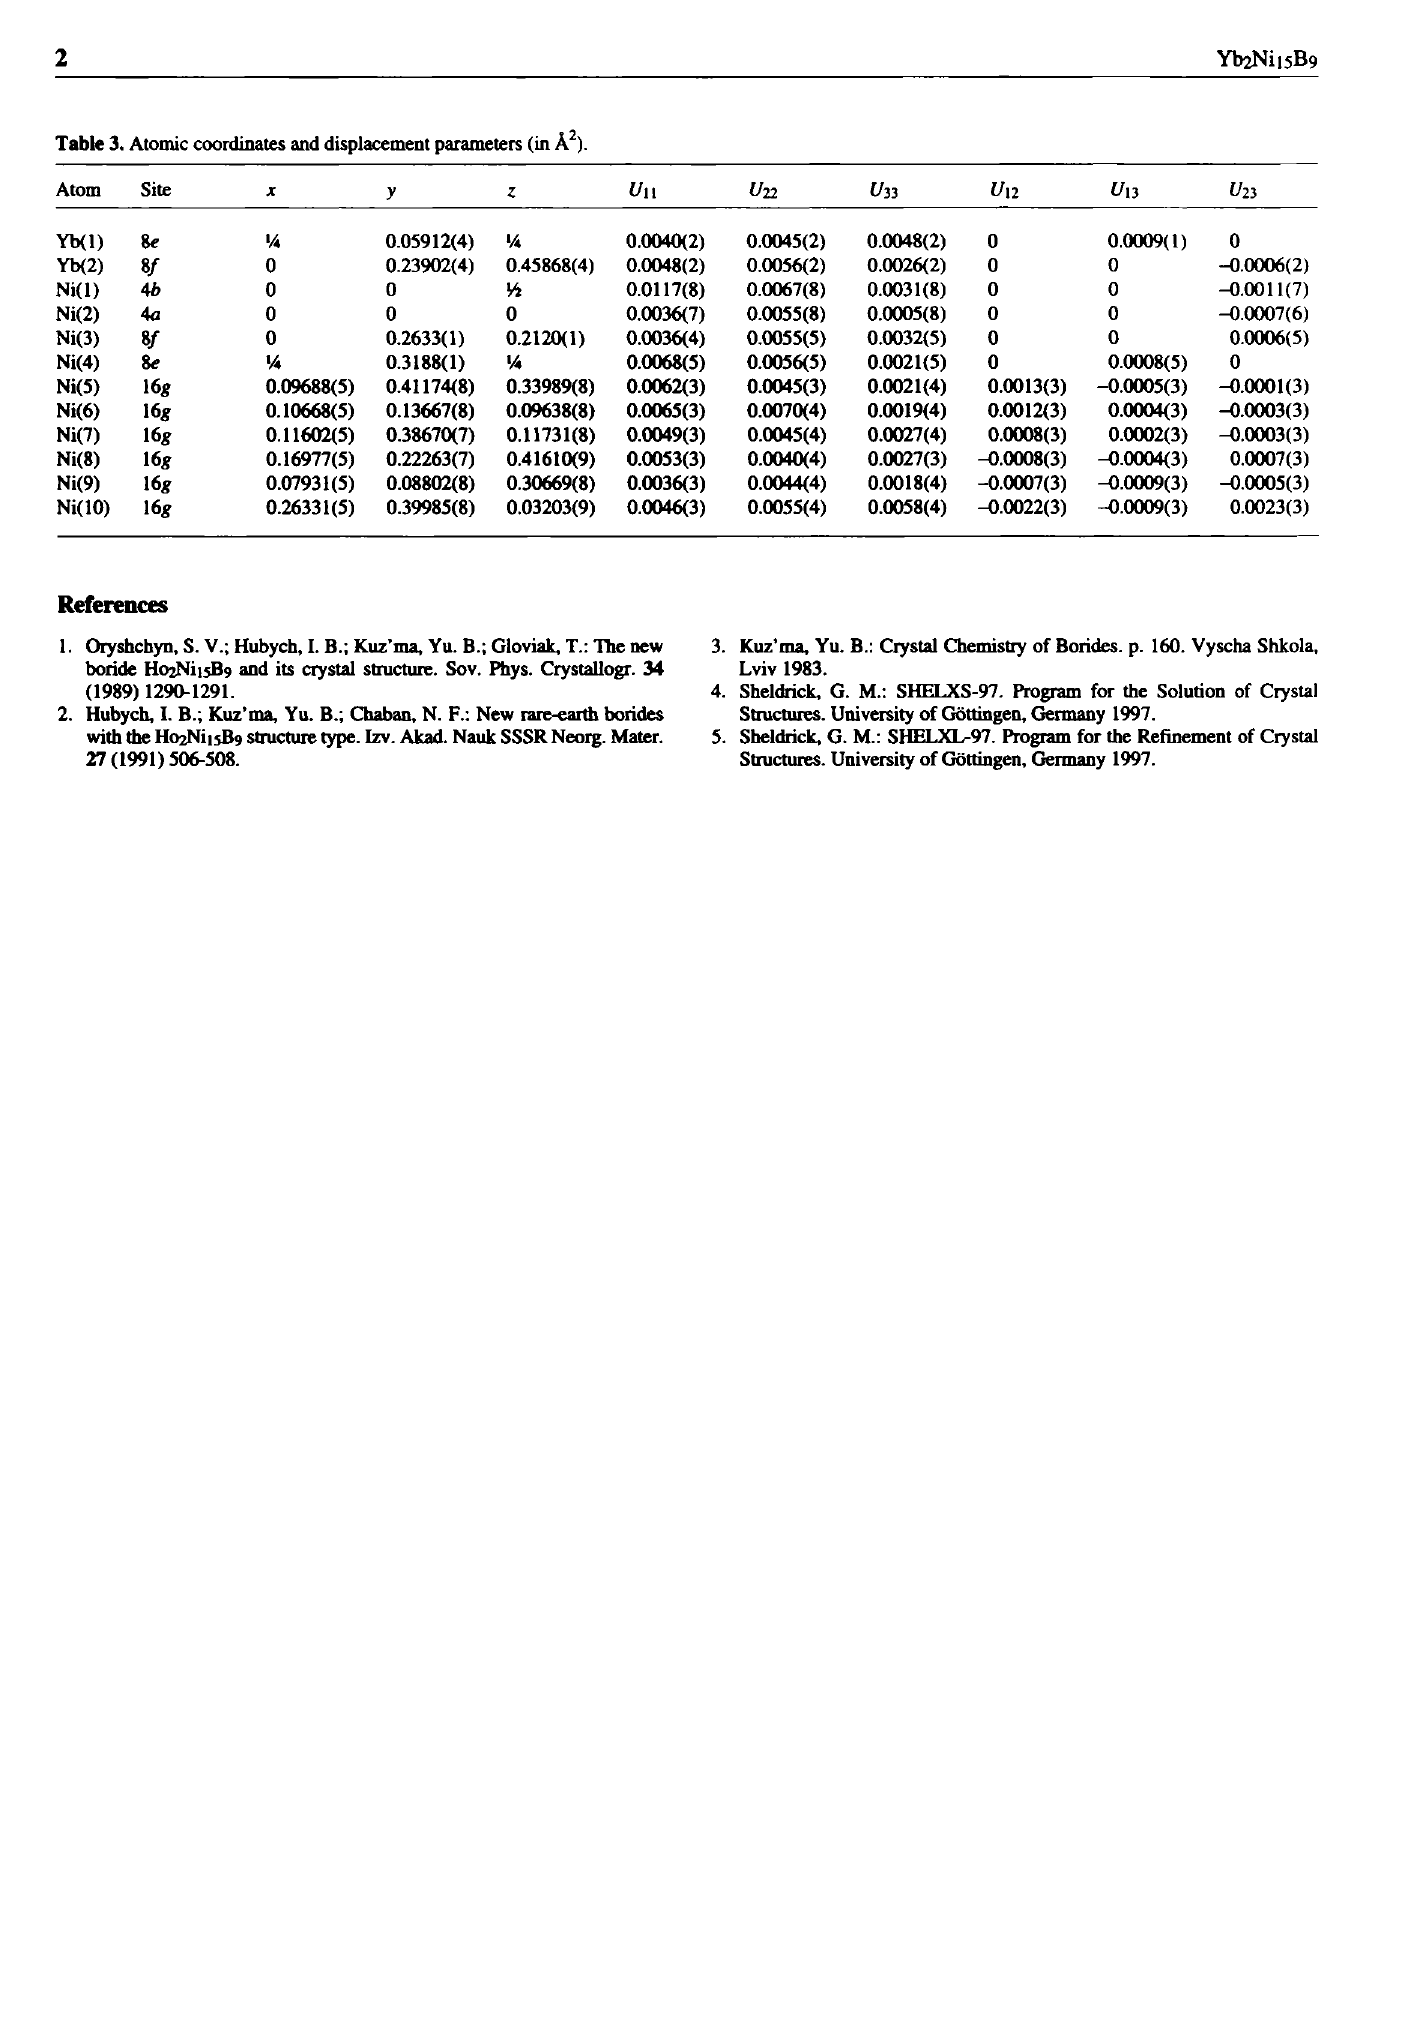
Table 3. Atomic coordinates and displacement parameters (in A 2